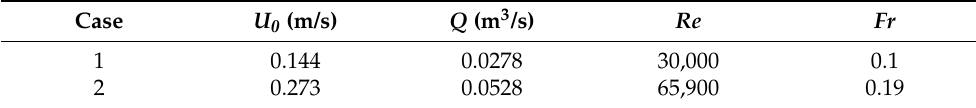
Figure 1. Three − dimensional view and the local grid of computed regions with the spur dike in Case 1 and Case 2. Table 1. Hydrological circumstances and computational details.